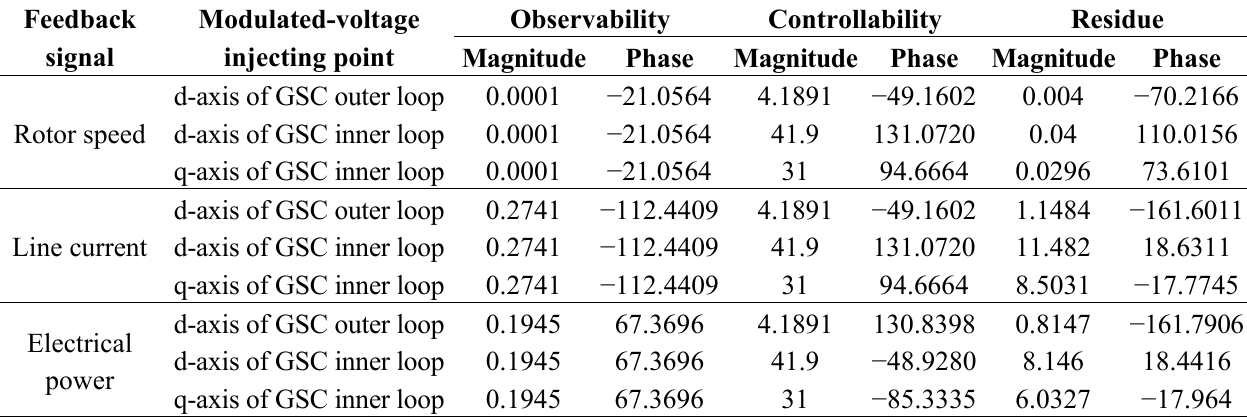
Table 2. Modal observability, controllability and residue for different feedback signals and modulated-voltage injecting points for the SSR